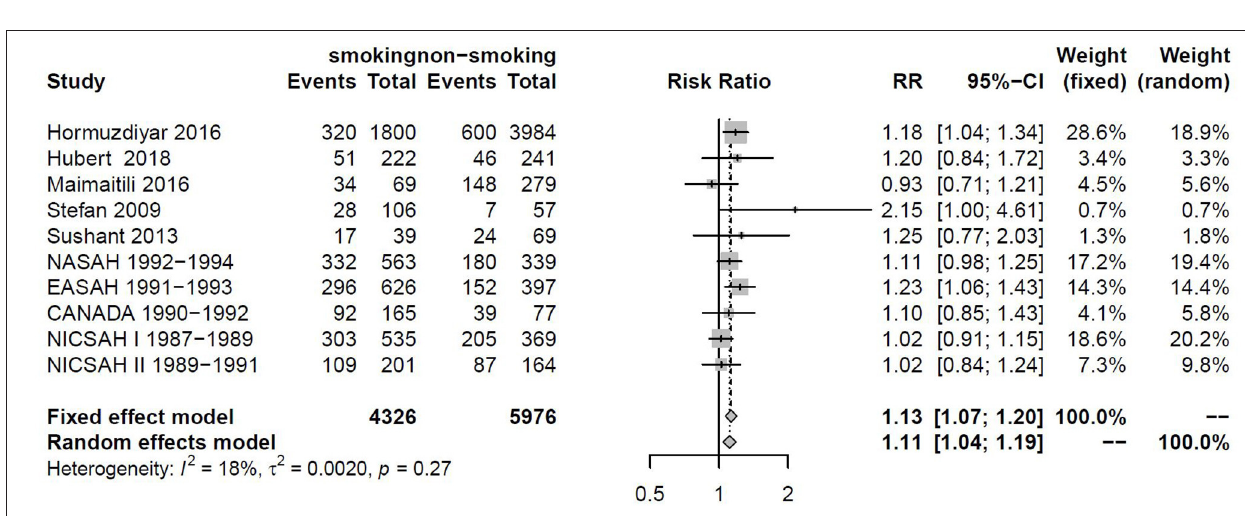
FIGURE 6 | Forest plot of smoking as one of the risk factors for DCI after removing heterogenous cohorts by sensitivity analysis.